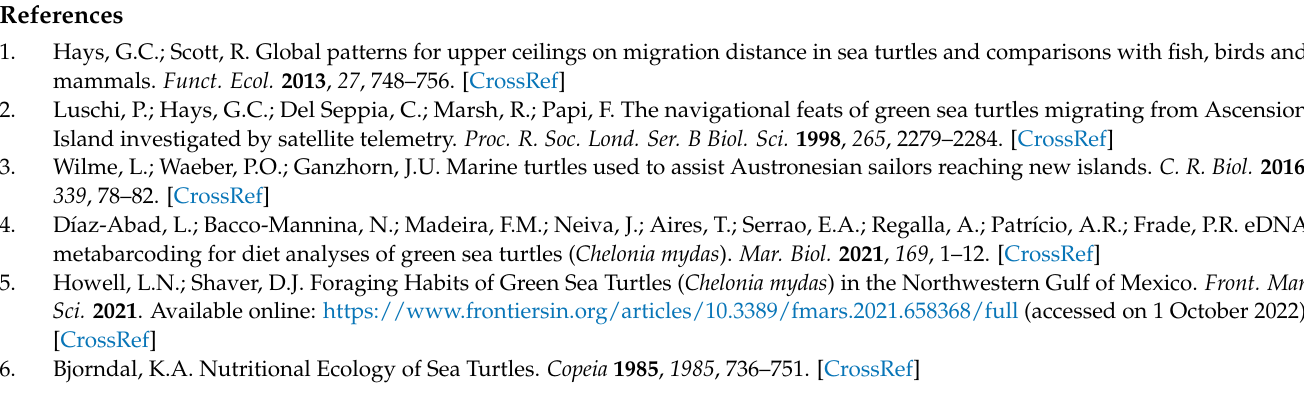
sections. Figure S2, 3D printed parts surface quality testing. Figure S3, lift force Sensitivity study results. Figure S4, Images of flow visualisation. Figure S5, CFD domain and results. Video S1: Supplementary video of flow